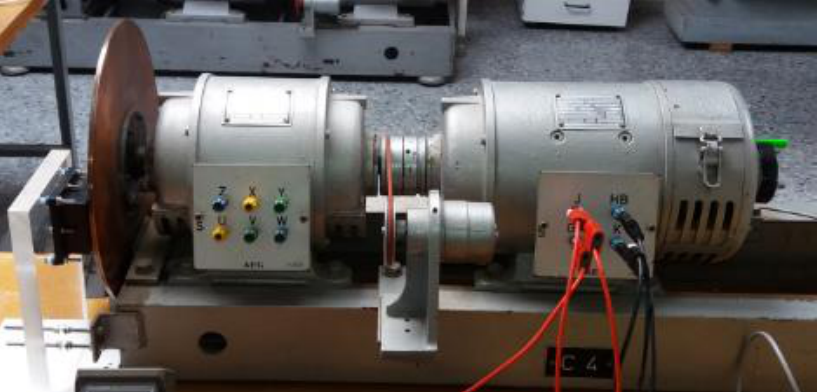
Figure 7. On the left the permanent magnet and copper disk, on the right the DC motor to modify the angular velocity w r